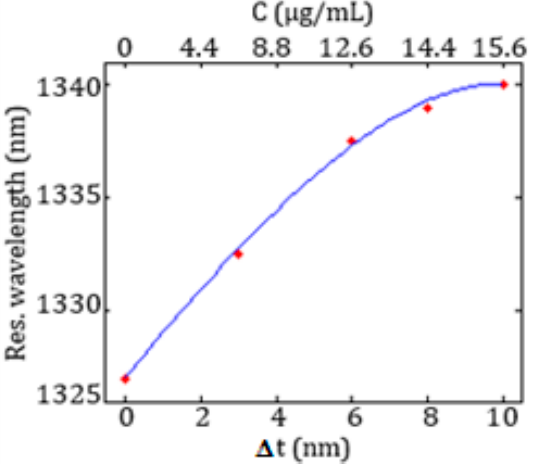
Figure 14. Resonance wavelength as a function of Δ t and concentration.